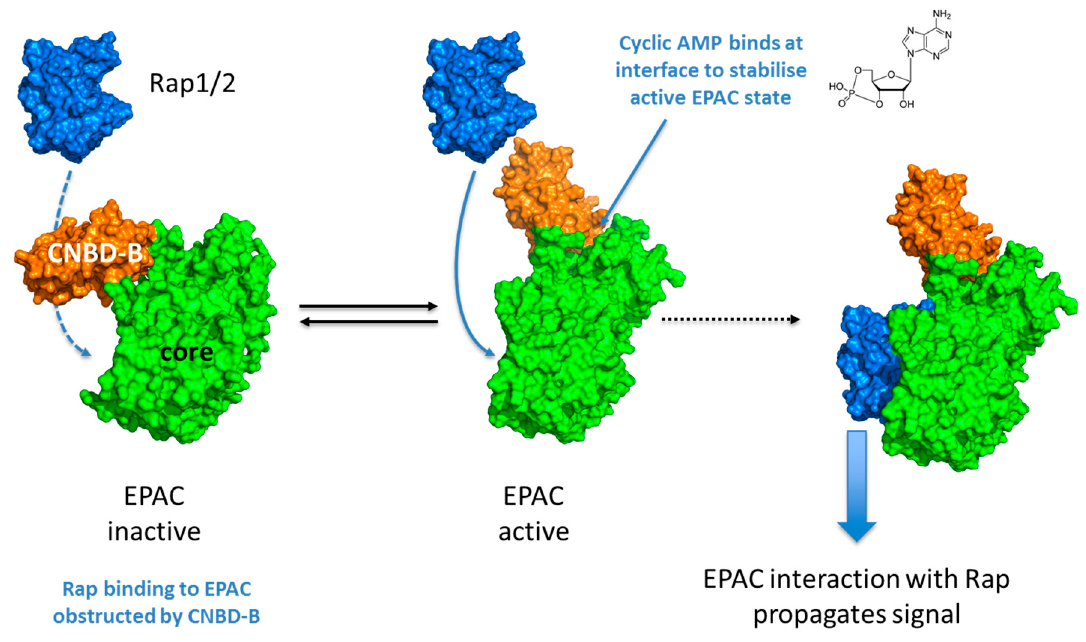
Figure 2. Activation of EPAC enzymes involves a conformational change triggered by the interaction of cyclic AMP with the EPAC CNBD-B.